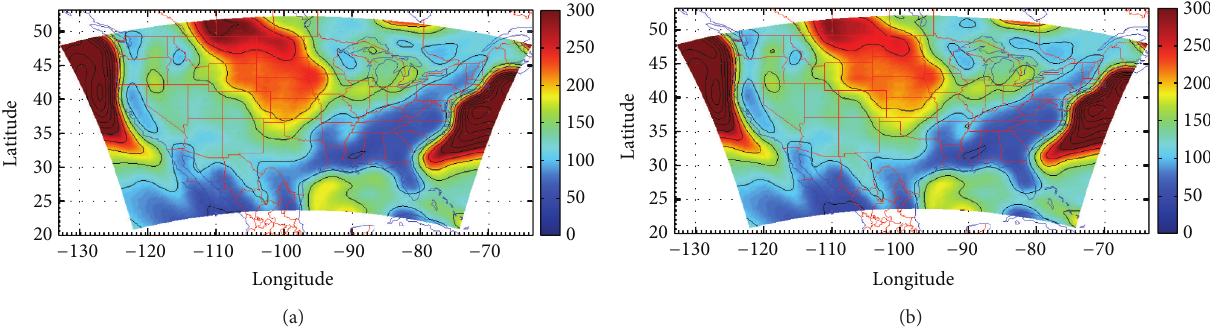
significant since these are regions in which wind energy engineering is most likely to be